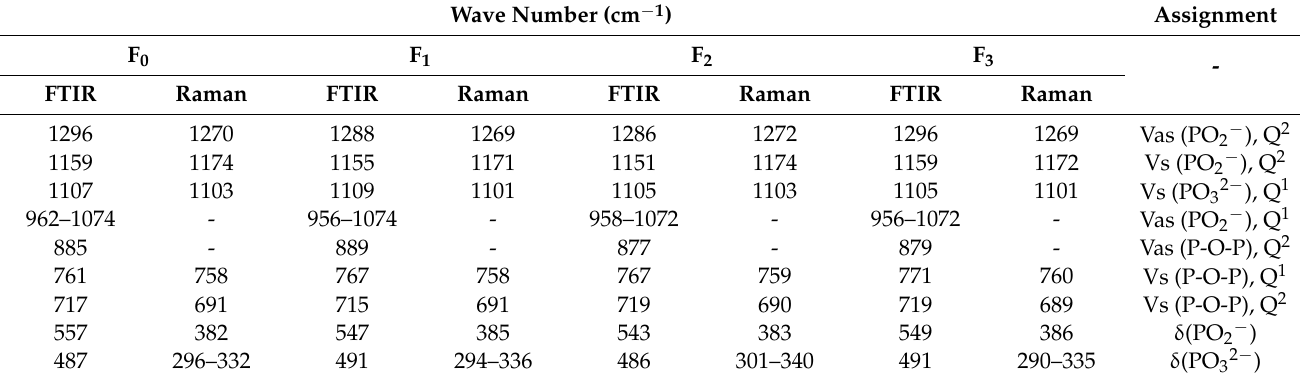
Table 4. Assignments and frequency ranges (cm − 1 ) of the FTIR and Raman bands of the prepared glasses.